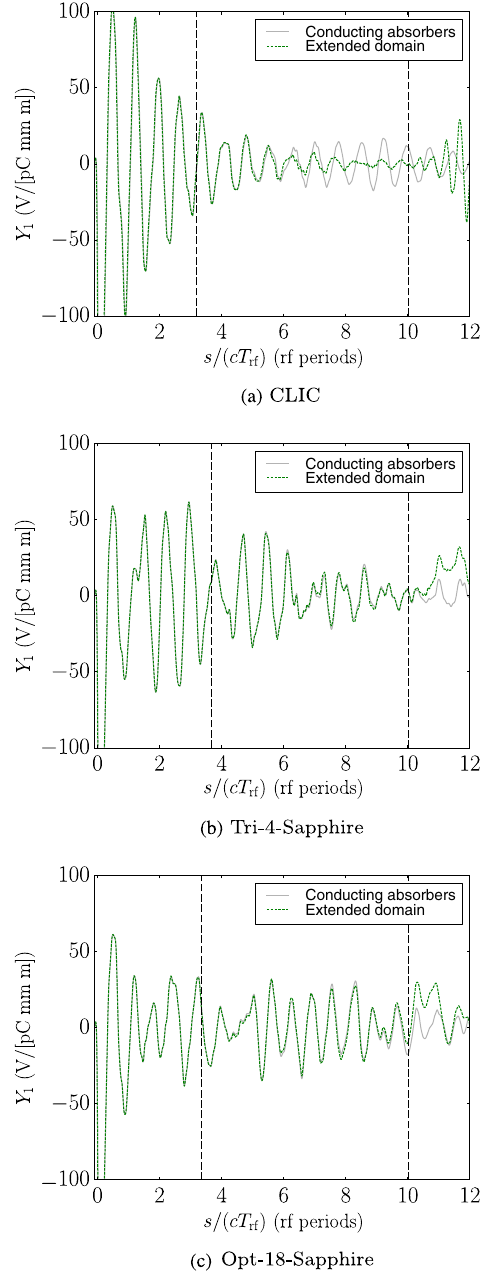
FIG. 16. Reflections off of the conducting absorbers cause differences in the wake potentials between the two vertical lines (more so in the CLIC cavity). Beyond the second line, reflections from the extended domain boundaries reach the cavity